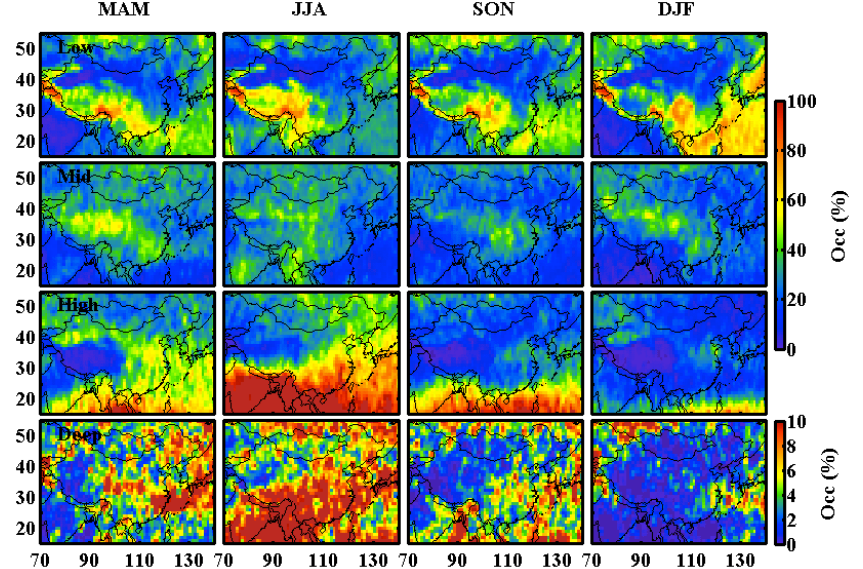
Figure 7. Seasonal variations of cloud occurrence distributions for low-level, mid-level, high-level, and deep clouds.